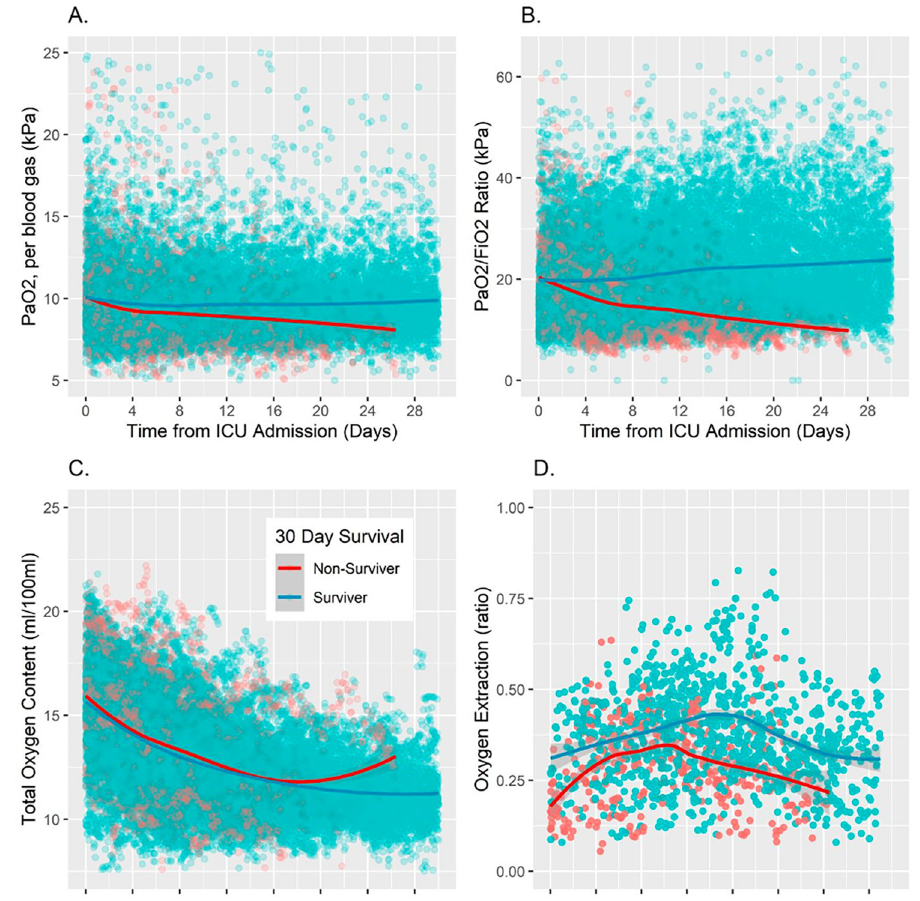
Fig 2. Blood oxygen indices over time between survivors and non-survivors. (A) PaO 2 (kPa), (B). PaO 2 / FiO 2 ratio (kPa), ( C). Total oxygen content (ml/dL), (D). Oxygen extraction ratio (O 2 ER).